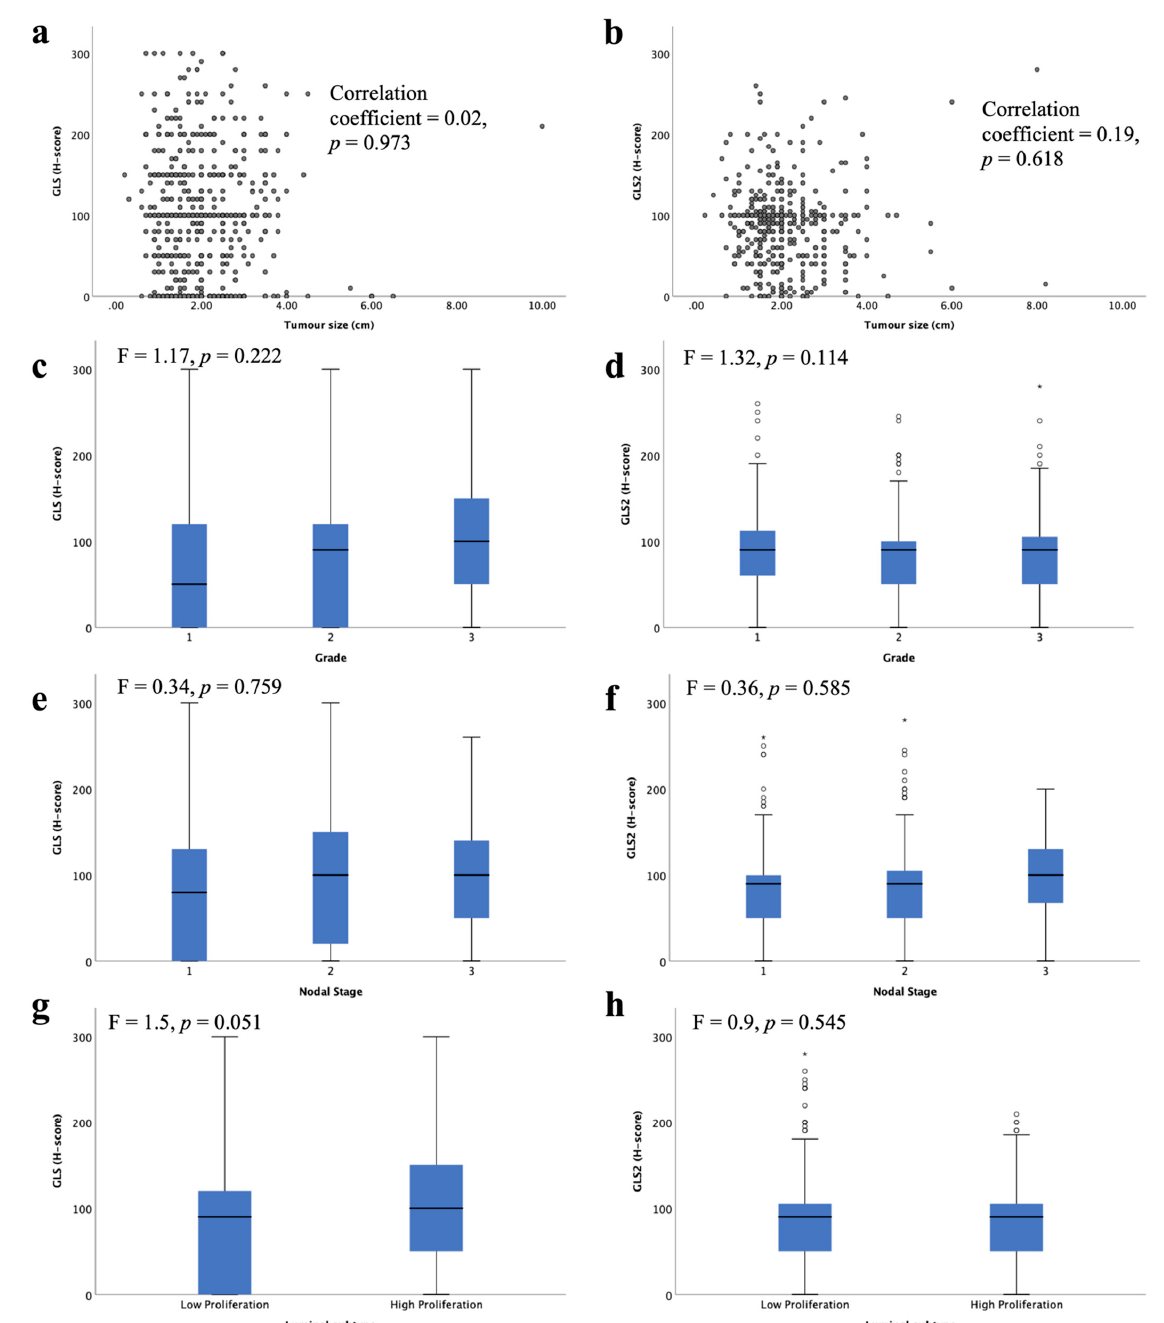
Figure 5. Glutaminase protein expression and its association with clinicopathological parameters and molecular subtypes in ER +/HER2- invasive breast cancer: GLS and ( a ) tumour size, ( c ), tumour grade, ( e ) lymph node stage, ( g ) luminal subtypes; GLS2 and ( b ) tumour size, ( d ) tumour grade, ( f ) lymph node stage, ( h ) luminal subtypes using one-way analysis of variance with the post-hoc Tukey test. Data represented with median ± standard deviation. Statistically significant p values are in bold.